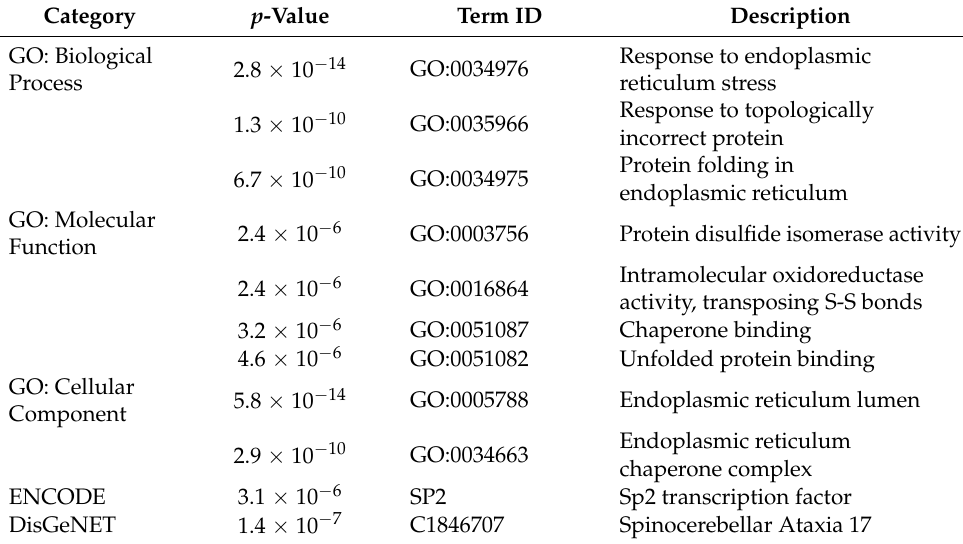
Figure 11. HGCA2.0 HSP90B1 5 internal node coexpression clade. Table 9. Selected top gene term enrichments of the coexpressed genes to HSP90B1 in HGCA2.0.